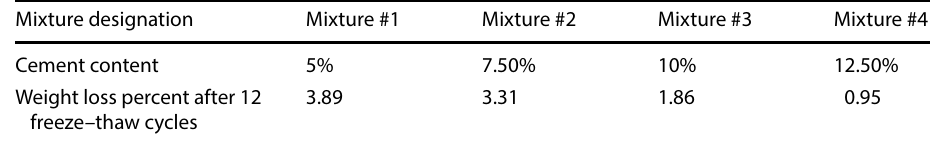
Table 5 The freeze–thaw test result for CSG